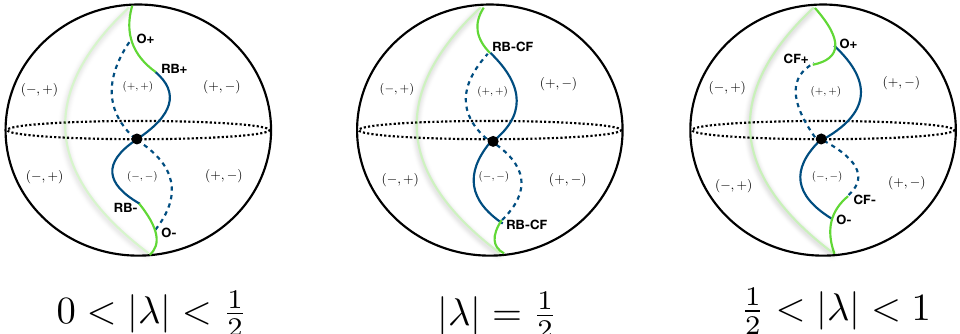
Figure 1. A schematic phase diagram for the N = 2 theory for three representative values of j (cid:21) j . The phase diagram is an ellipsoid (displayed here as a sphere for simplicity) in the three dimensional space spanned by the relevant parameters m 2 , (cid:21)b 4 and m F sgn( (cid:21) ). The northern (southern) hemi- B sphere corresponds to m F sgn( (cid:21) ) > 0 ( m F sgn( (cid:21) ) < 0) while the left (right) hemisphere corresponds to m 2 > 0 ( m 2 < 0). The notation ( (cid:6) ; (cid:6) ) corresponds to the four low energy topological phases B B described in table 1. The blue lines are second order transition lines and are governed by either CS gauged Wilson-Fisher bosons (solid lines) or CS gauged free fermions (dashed lines). The green line in each of the above (cid:12)gures is a (cid:12)rst order phase transition line | part of it lies on the far side of the ellipsoid in the viewpoint depicted above. For j (cid:21) j < 1 the (cid:12)rst order line meets the solid 2 blue lines at one point each in the two hemispheres of the ellipsoid governed by CS gauged free boson CFTs (RB (cid:6) ). For j (cid:21) j > 1 these points are governed by CS gauged Gross-Neveu fermions 2 (CF (cid:6) ). For j (cid:21) j = 1 , the (cid:12)rst order line meets the solid and dashed lines at one point each in 2 the two hemispheres which are governed by a theory of CS gauged free bosons plus Gross-Neveu fermions (RB-CF). The blue lines all intersect at the black dot on the equator and is governed by a theory of CS gauged Wilson-Fisher bosons plus free fermions (CB-RF). The phase diagrams for j (cid:21) j < 1 and j (cid:21) j > 1 are related to each other by the duality map (1.3). The diagram for j (cid:21) j = 1 is 2 2 2